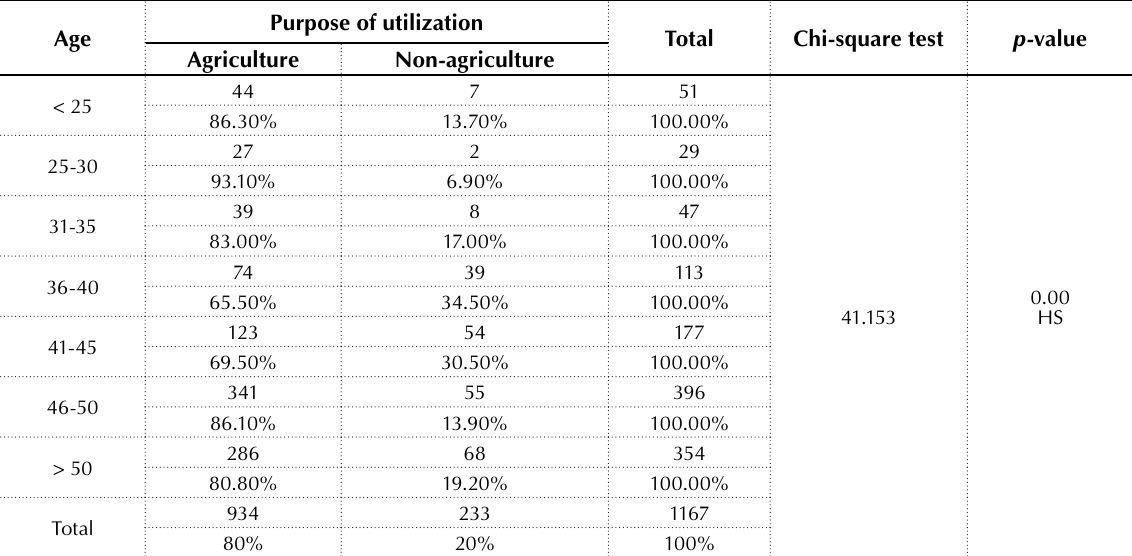
Table 3. Impact of age on the purpose of agricultural credit utilization